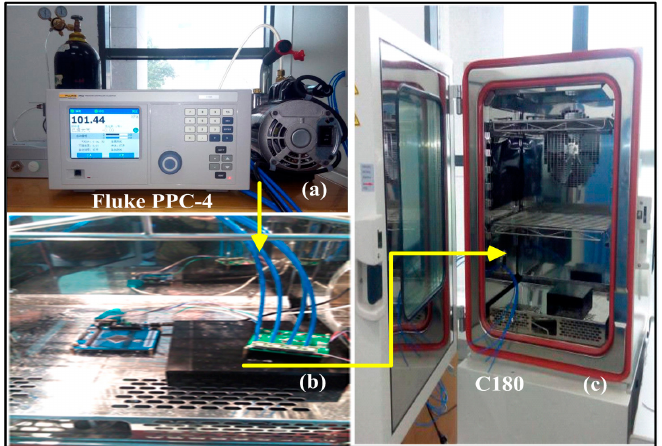
Figure 6. Photographs of calibration and test experimental setups: ( a ) Fluke PPC-4 standard pressure generator; ( b ) Digital MEMS-array pressure transmitter in constant temperature chamber; ( c ) C180 constant temperature and humidity